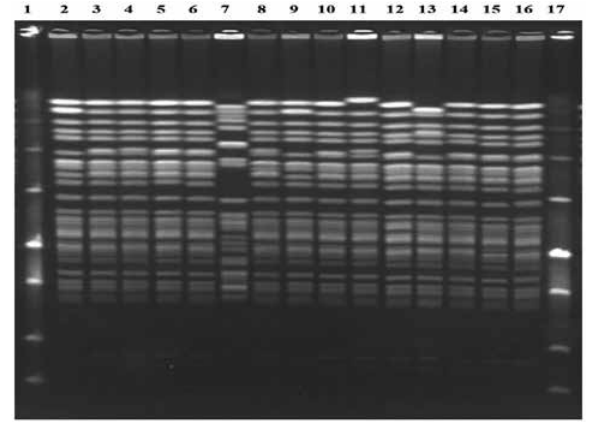
Figure 2: PFGE results of all VRE isolates